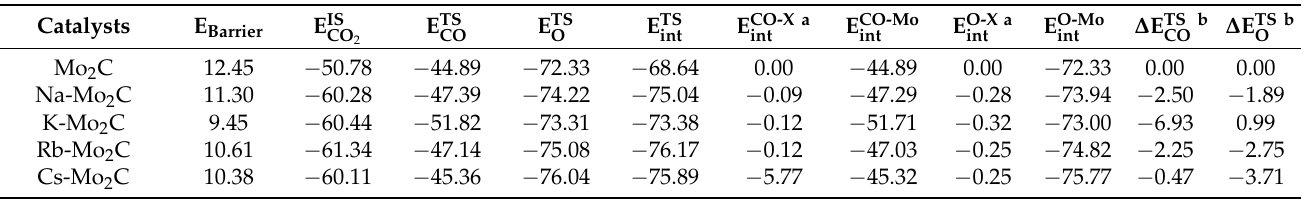
Table 2. Energy decomposition of the calculated activation barriers for the dissociation of CO 2 on bare Mo 2 C and X-Mo 2